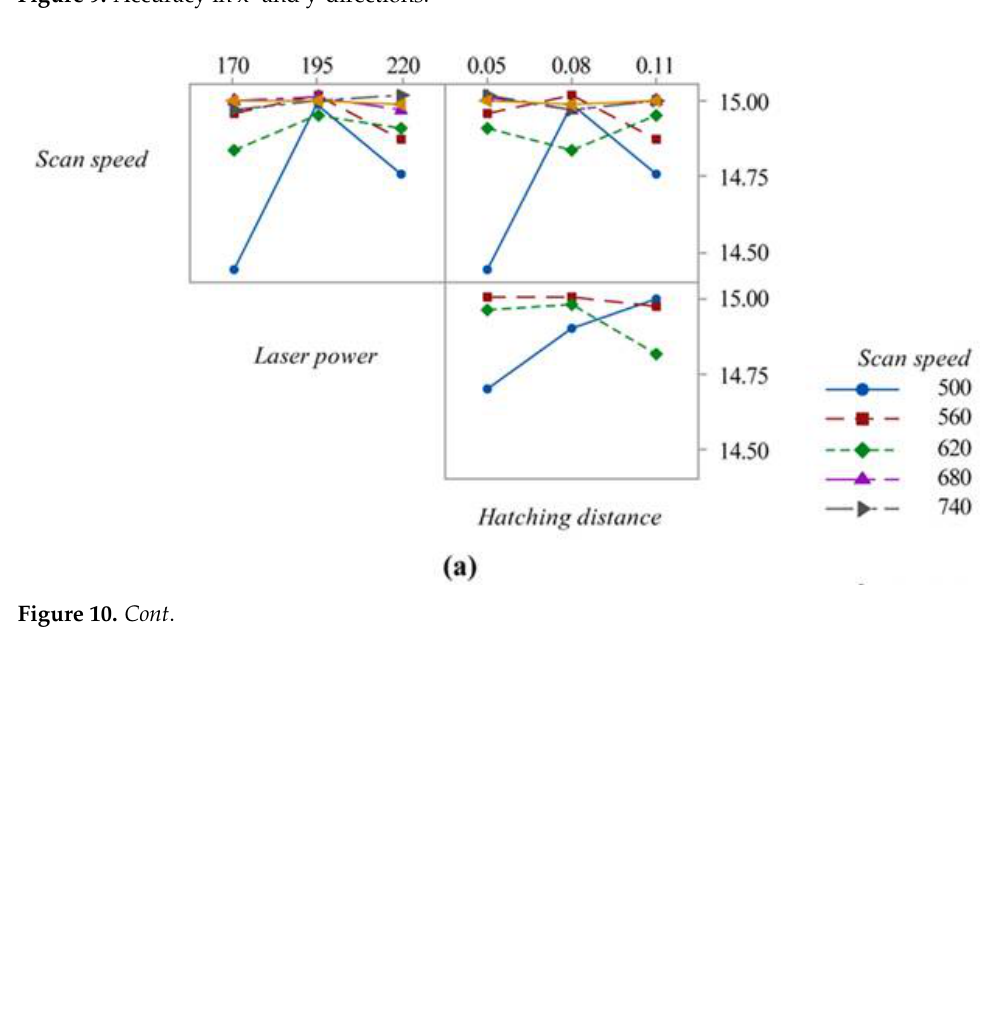
Figure 10. Interaction plot between process parameters and accuracy: ( a ) x-direction, ( b ) y-direc- tion. 4. Conclusions Cu-10Sn samples were fabricated with the additive L-PBF process using a 500 W Yb:YAG laser and the effect of the process parameters on density, microhardness, surface roughness and accuracy was examined. A design of experiment based on the Taguchi method was employed to reduce the number of samples from 54 to 18. The main conclu- sions are as follows: 